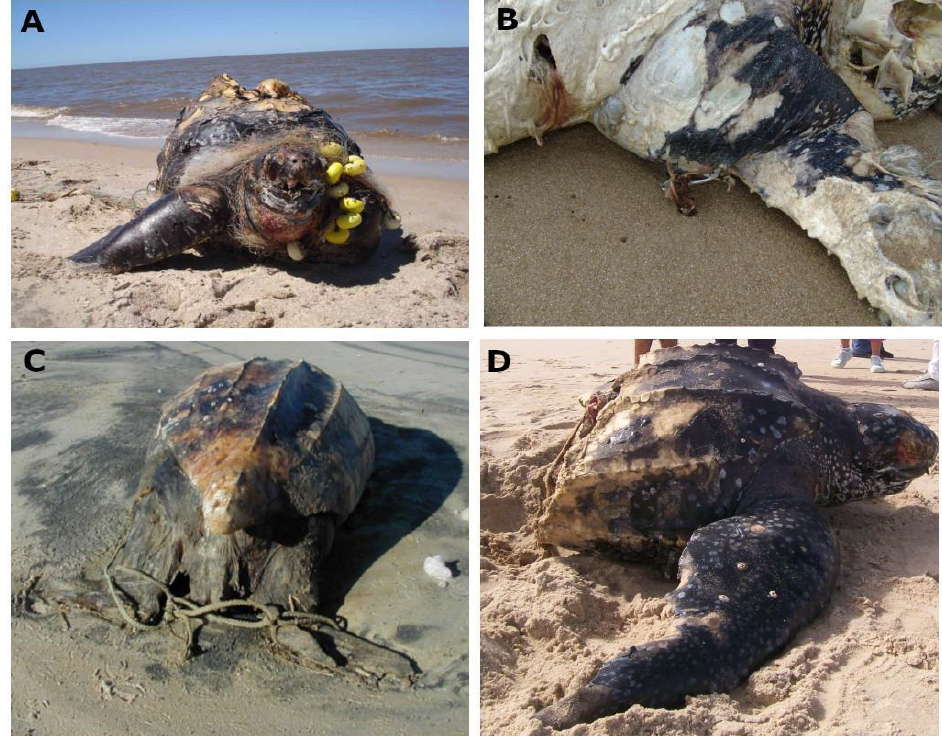
Figure 6. Stranded leatherback carcasses with evidence of human-caused interactions. ( A ) Artisanal set net entanglement, ( B ) longline fishing hook in the front flipper, ( C ) ropes probably used by fishers set net entanglement, ( B ) longline fi shing hook in the front fl ipper, ( C ) ropes probably used by fi sh- to move the turtle on an industrial fishing boat, and ( D ) leatherback cut in two pieces probably ers to move the turtle on an industrial fi shing boat, and ( D ) leatherback cut in two pieces probably associated with boat collision. Photo credits: Karumbé. associated with boat collision. Photo credits: Karumb é